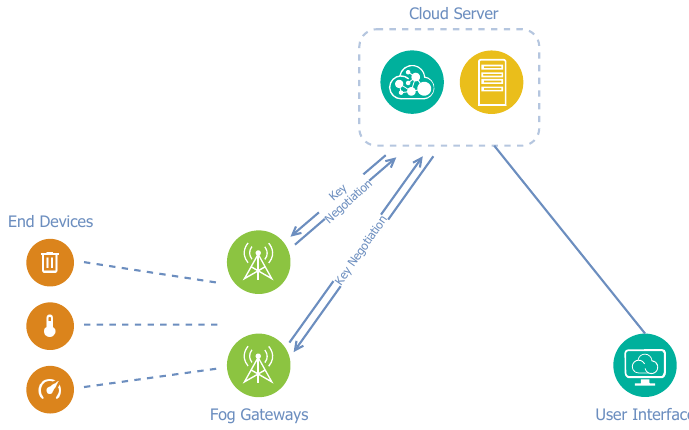
Figure 5. Diagram of network architecture